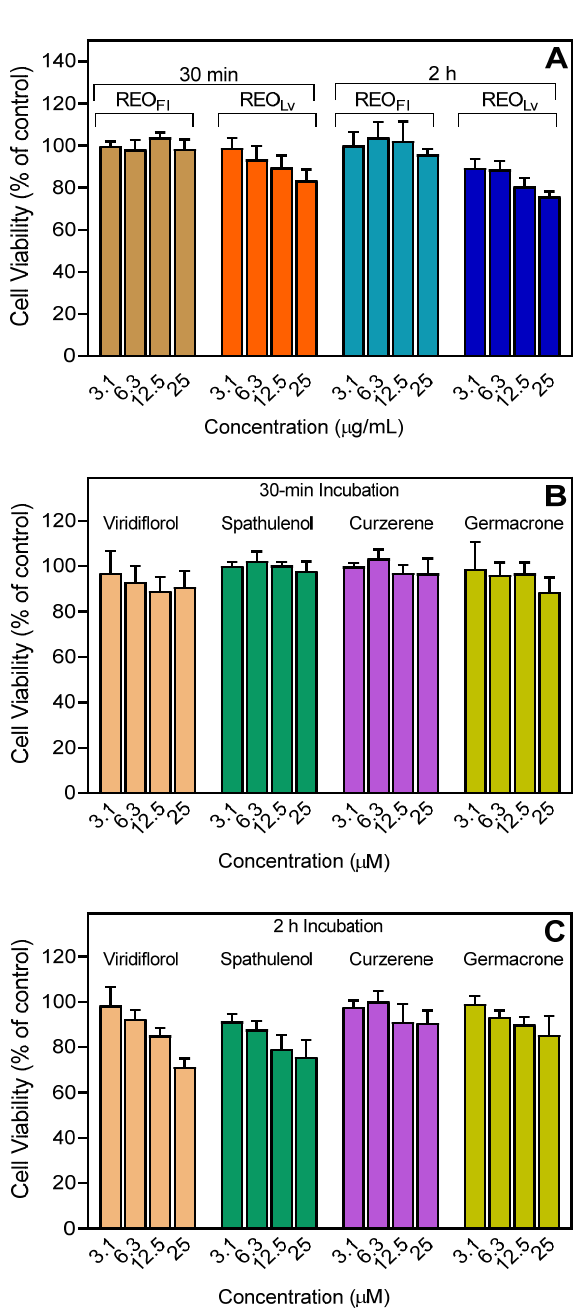
Figure 6. Cytotoxicity of REO Lv , REO Fl , and selected sesquiterpenes. HL60 cells were preincubated with REO Lv or REO Fl ( A ) or pure compounds ( B , C ) for 30 min and 2 h, and cell viability was analyzed, as described. Values are the mean ± SD of triplicate samples from one experiment that is representative of two independent experiments with similar results.